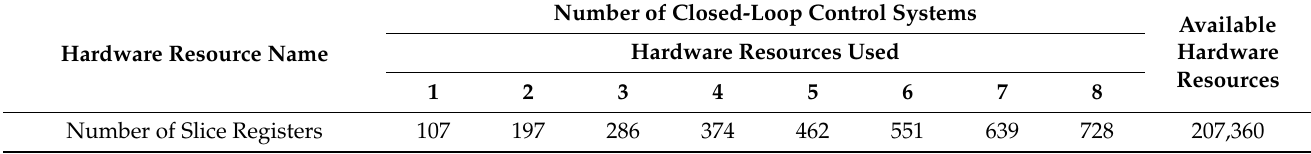
Table 3. Utilization of FPGA hardware resources for different numbers of closed-loop control